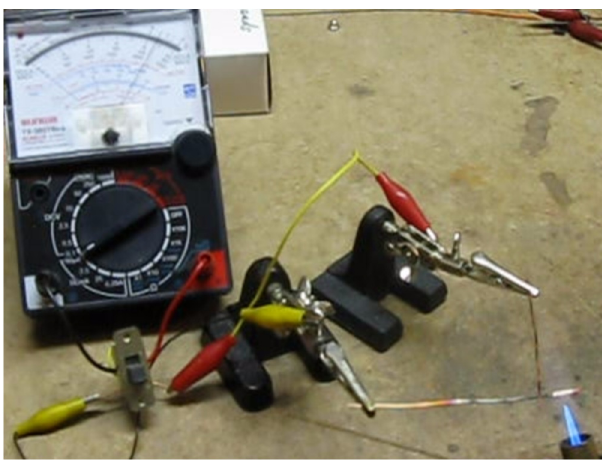
Figure 4. Thermoelectric copper oxide generator.